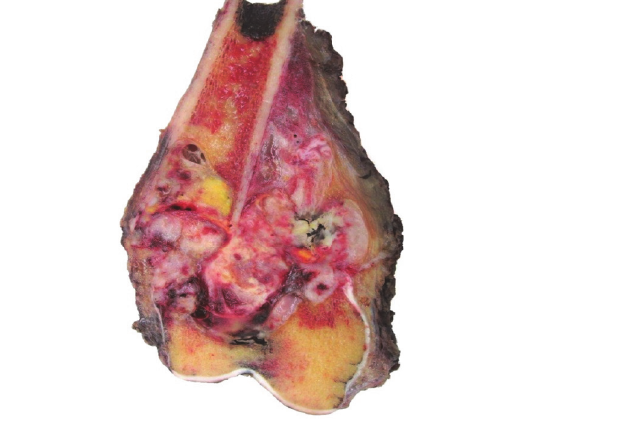
Figure 4: Showing gross pathology of the resected tumor showing an aggressive lesion with expansion beyond the cortices of the distal femur and into the soft tissue and new bone formation within the lesion.